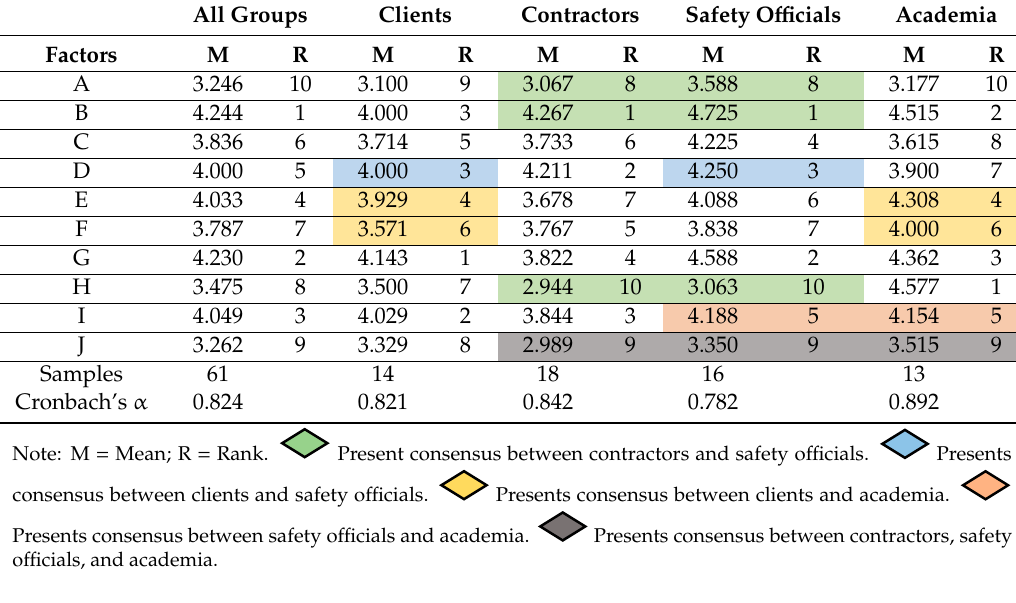
Table 4. First Round of Delphi Survey.